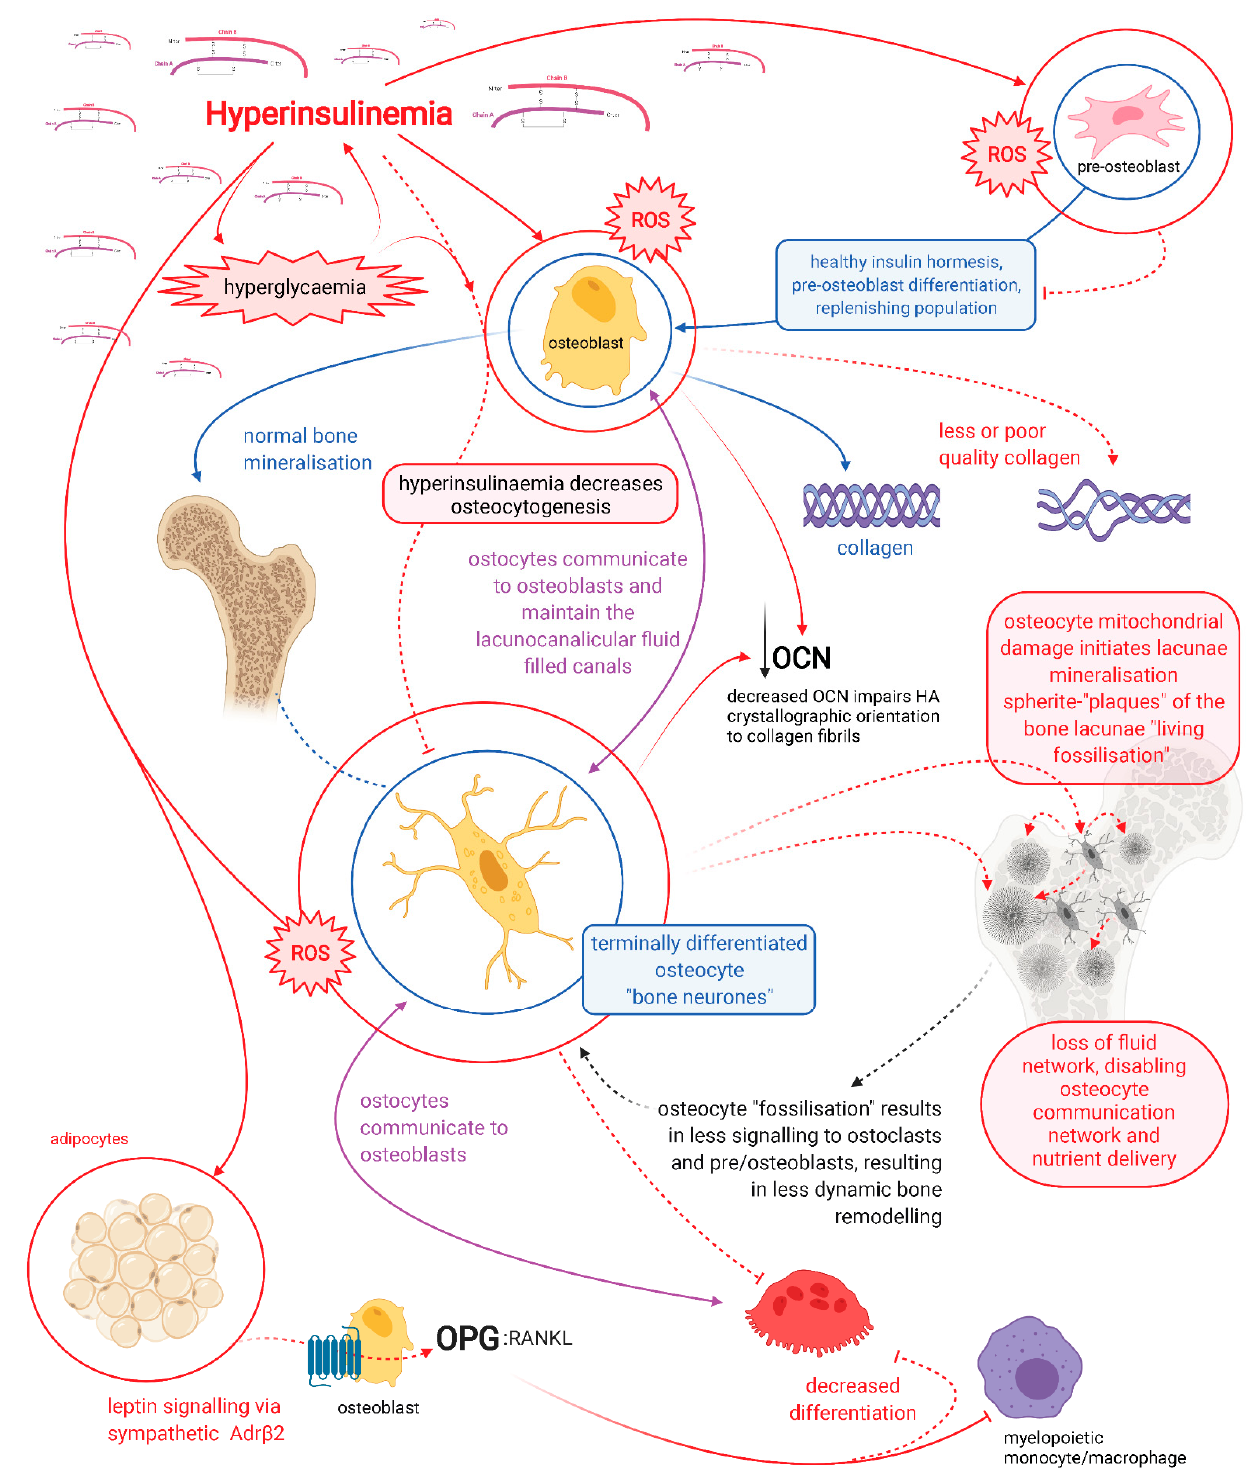
Figure 1. Schematic representation showing the dynamic role of osteocytes in the regulation of healthy and dysregulated bone. Beta-adrenergic receptor (Adr β 2), hydroxyapatite (HA), osteocalcin (OCN), osteoprotegerin (OPG), receptor activator of nuclear factor kappa- β ligand (RANKL), and reactive oxygen species (ROS). Red lines indicate hyperinsulinaemia-driven pathology pathways. Healthy physiology indicated with blue and purple lines.